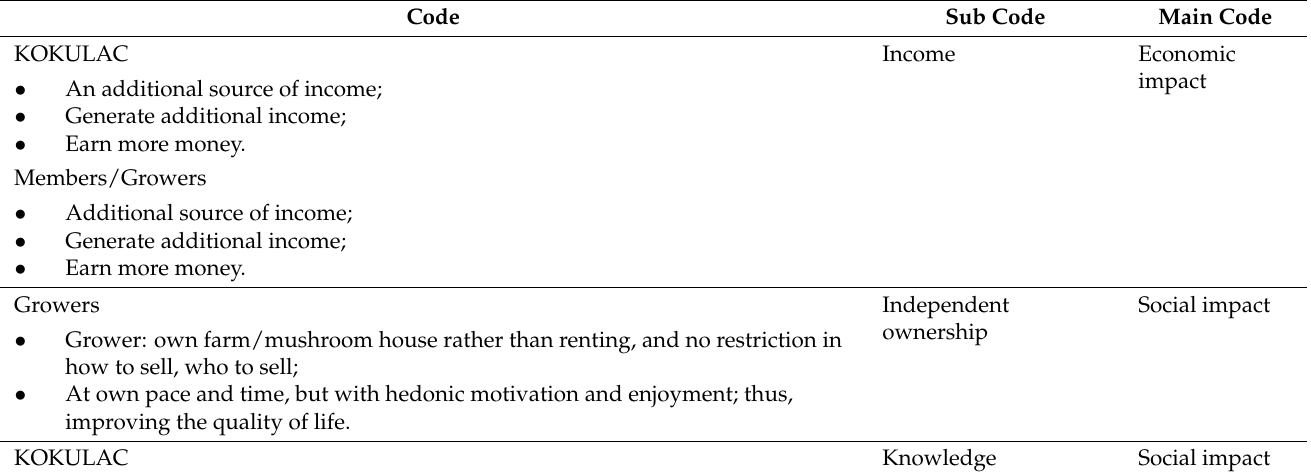
Table 2. The data